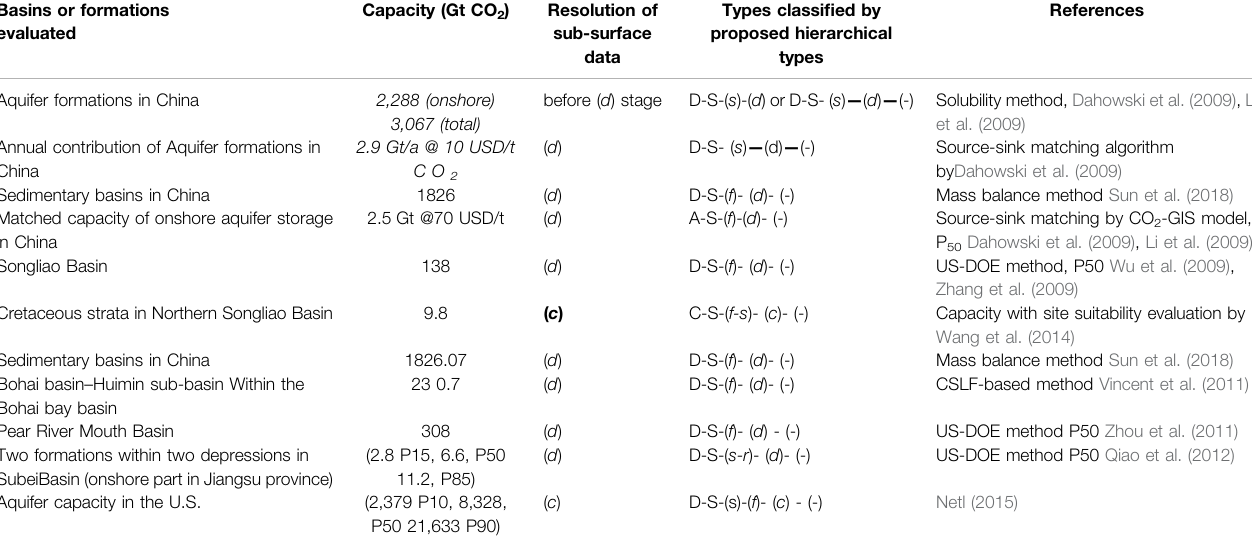
TABLE 5 | Capacity assessment of aquifer storage at various scales in China. Basins or formations evaluated